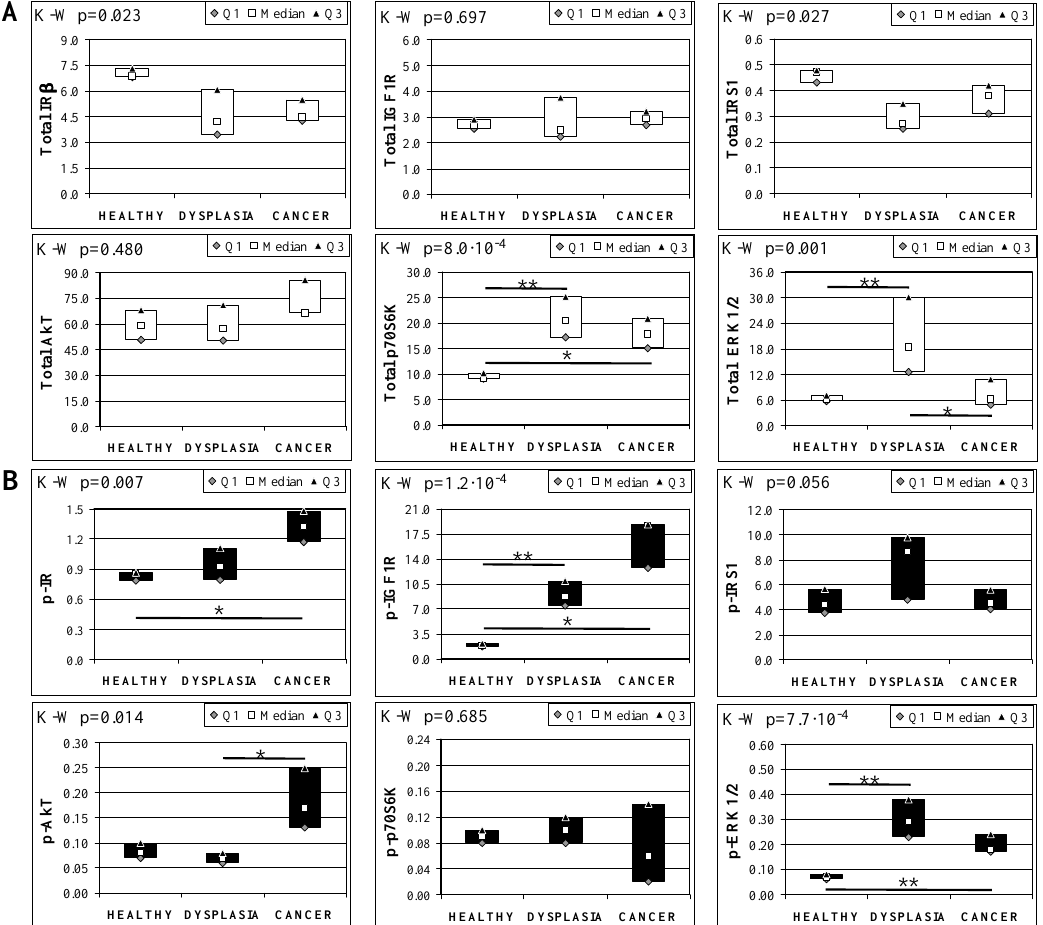
Figure 3. Insulin signaling in operated WT male mice esophageal tissue. Data are represented as Median (Q1; Q3). Data obtained in operated mice affected by dysplasia or cancer were compared to strain-, sex-, and age-matched, non-operated animals (43 weeks). K-W indicates the Kruskal-Wallis test result, used for multiple comparisons among the three groups of mice. The Mann-Whitney U-test was performed to compare data distribution between two groups of mice. A p -value lower than 0.016 (Bonferroni adjustment) was considered statistically significant: * p < 0.016; ** p < 1.6 × 10 − 3 . ( A ) Total protein expression: the quantity of each total protein considered was expressed in ng/100 mg of total protein extracted by the distal mice esophageal segment. ( B ) Phosphorylated protein expression: the amount of the six phospho-proteins considered was expressed as phosphorylated Units for each ng of the corresponding total protein amount. Proteins were quantified by Luminex-xMAP Technology on the basis of a standard curve. Beta-tubulin expression was used as the internal loading